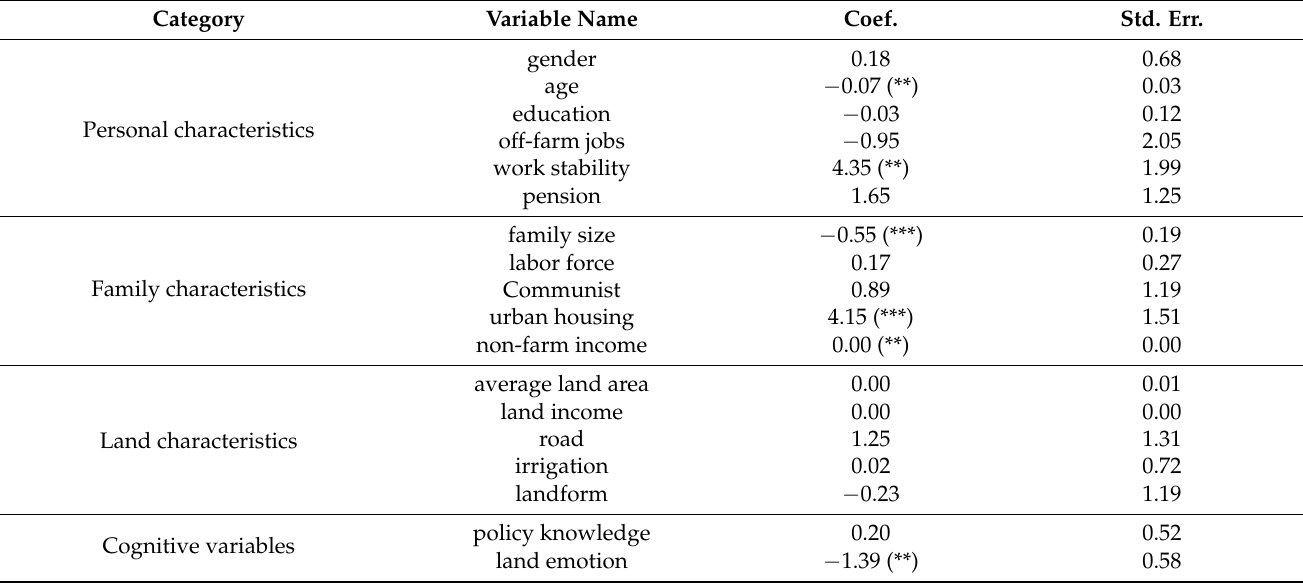
Table 5. Outcome estimates in Heckman sample selection model regression